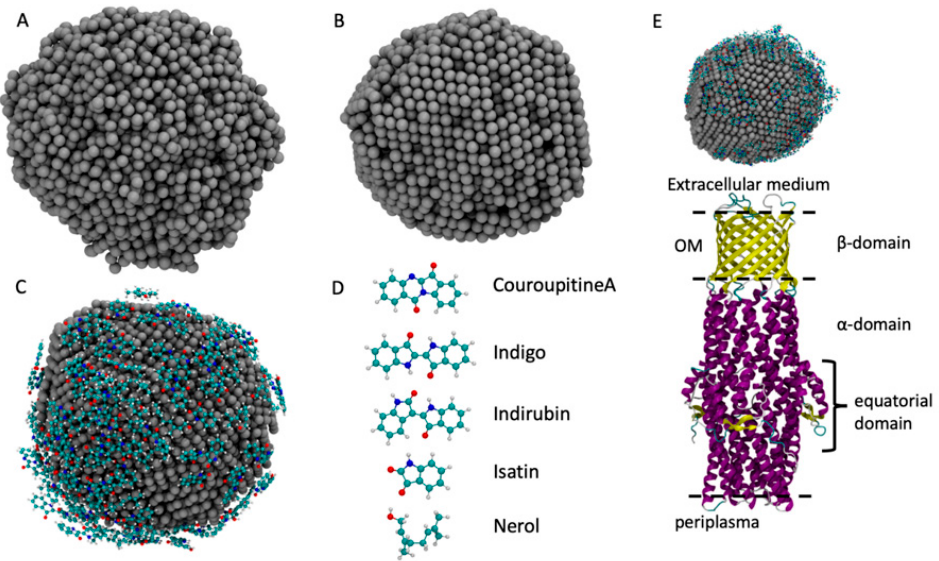
Figure 2. The models of the AgNP obtained from MD simulation: ( A ) the liquid phase of the AgNP at 2500 K; ( B ) the solid phase at 300 K; ( C ) the AgNP covered by molecules; ( D ) the five molecules employed in this work; ( E ) the starting configuration of the ST50 outer membrane protein of S. typhimurrium and of the C. guianensis AgNP.